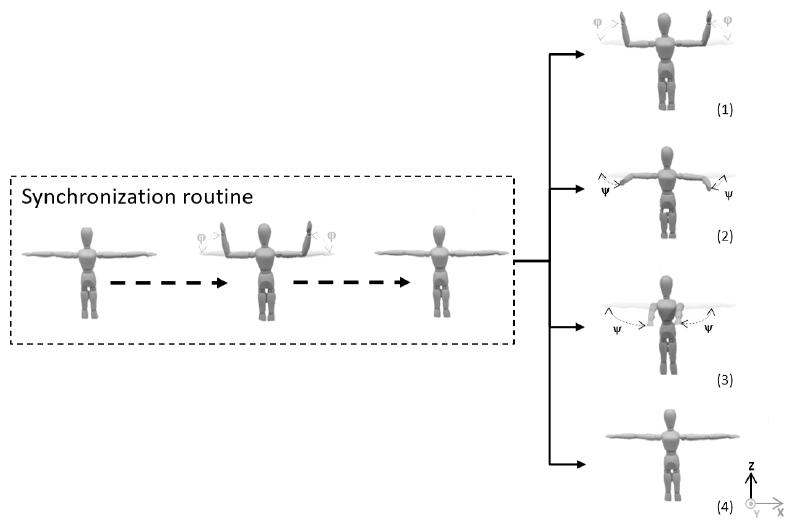
Figure 16. Movement sequences performed during